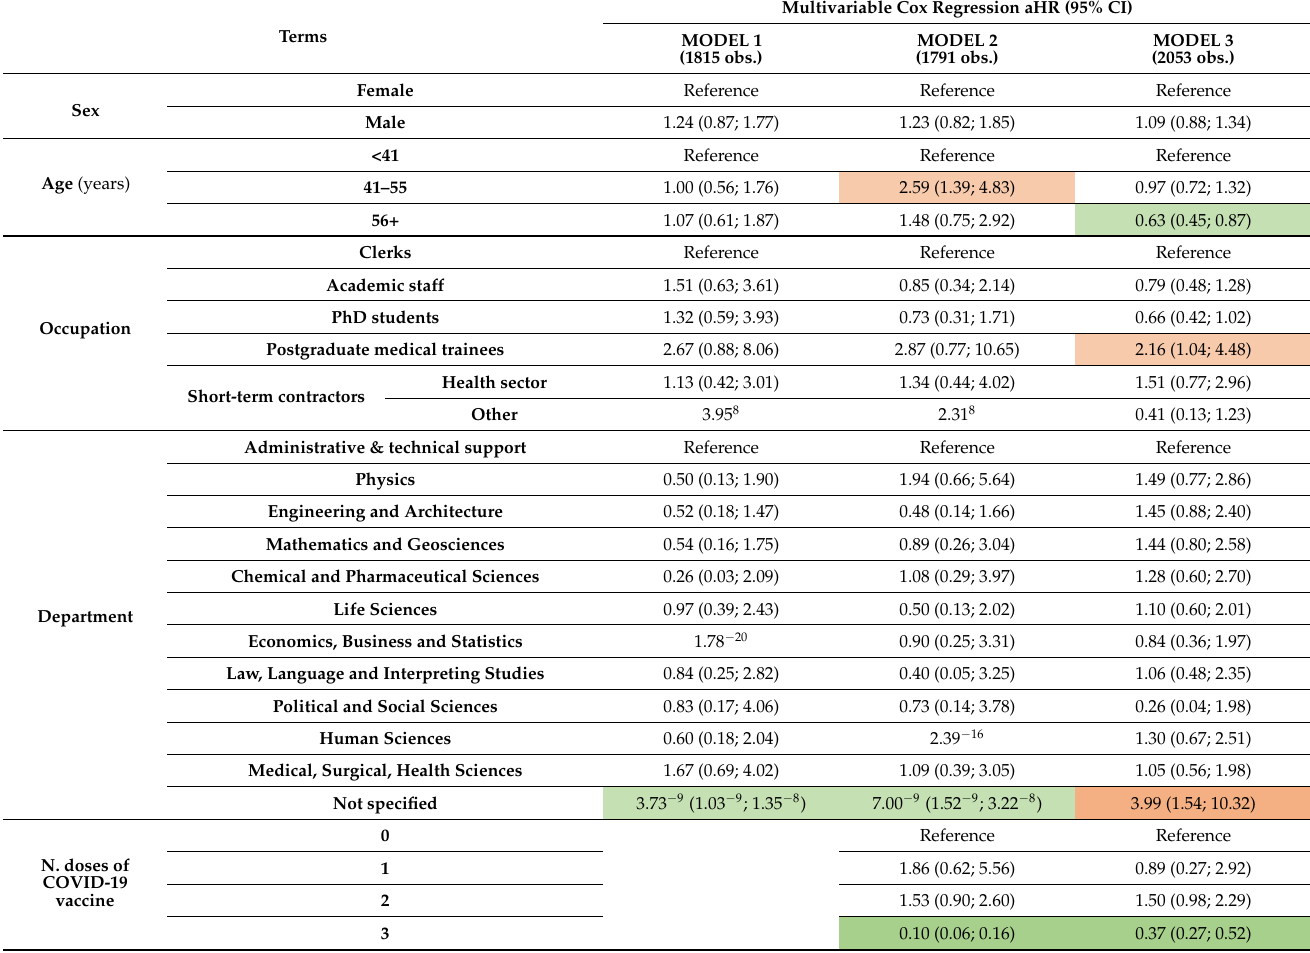
confidence interval (95% CI). Obs. = complete analysis observations.